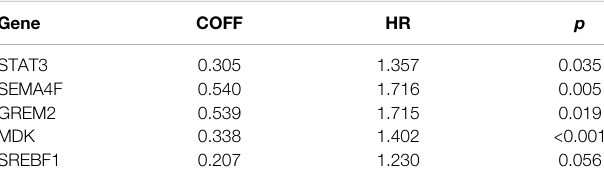
TABLE 1 | Details of features selected bythe multivariate Cox proportional hazard regression model with LASSO